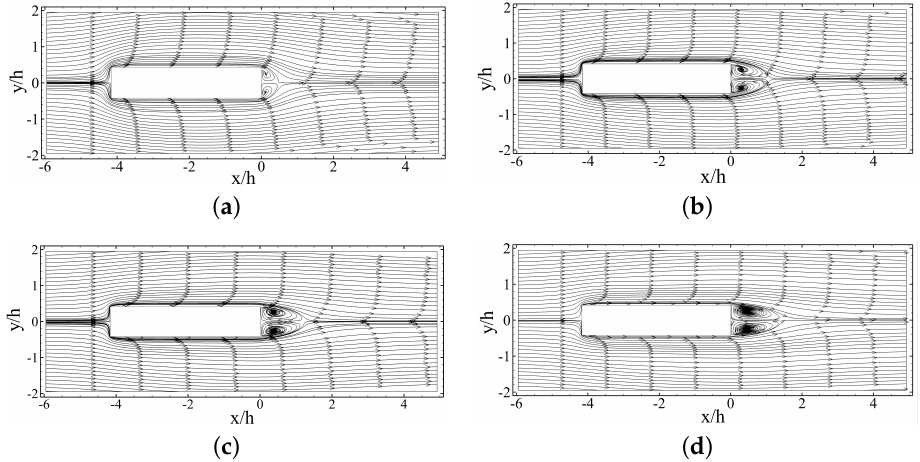
Figure 26. Streamlines on a top view ( xy -) of the long prism ( DR = 4.17) at z / h = 0.5. Re = ( a ) 50; ( b ) 150; ( c ) 200 and ( d )